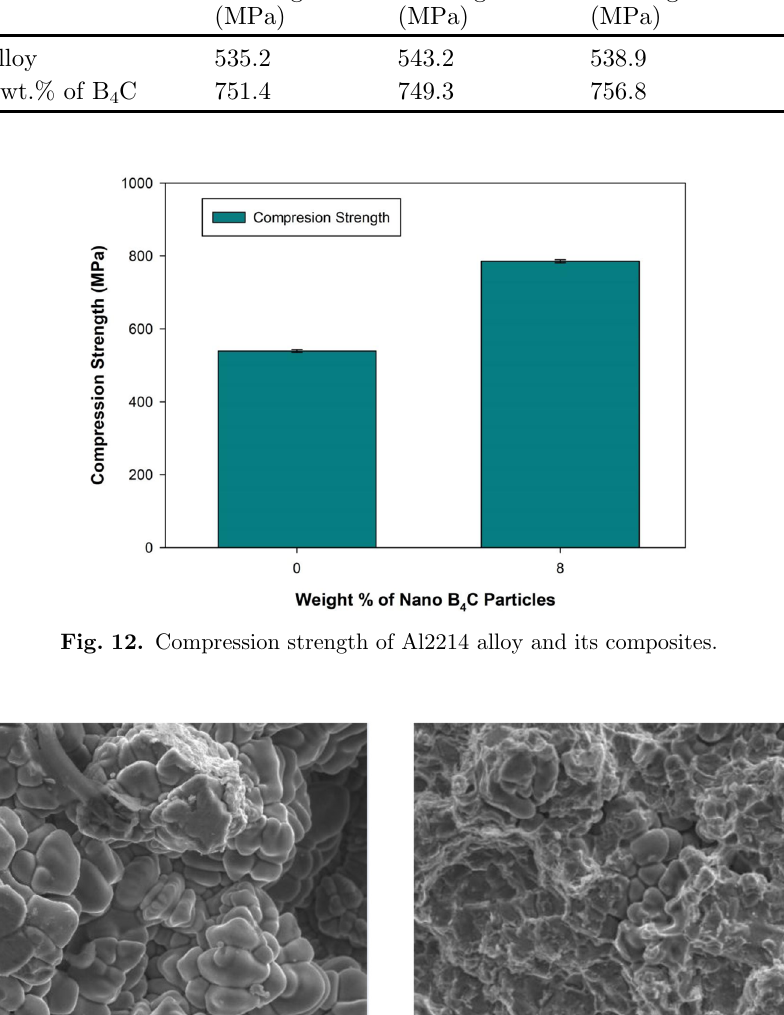
Table 6. Compression strength of Al2214 alloy and B Sl No.